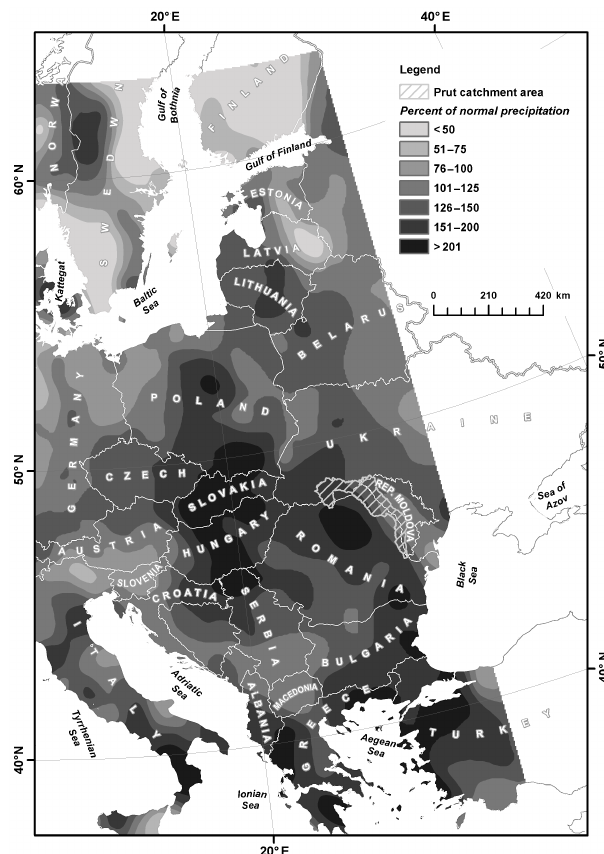
Figure 4. Cumulative precipitation for May–July (2010) interval, divided by normal precipitation – Climate Prediction Center (source data from